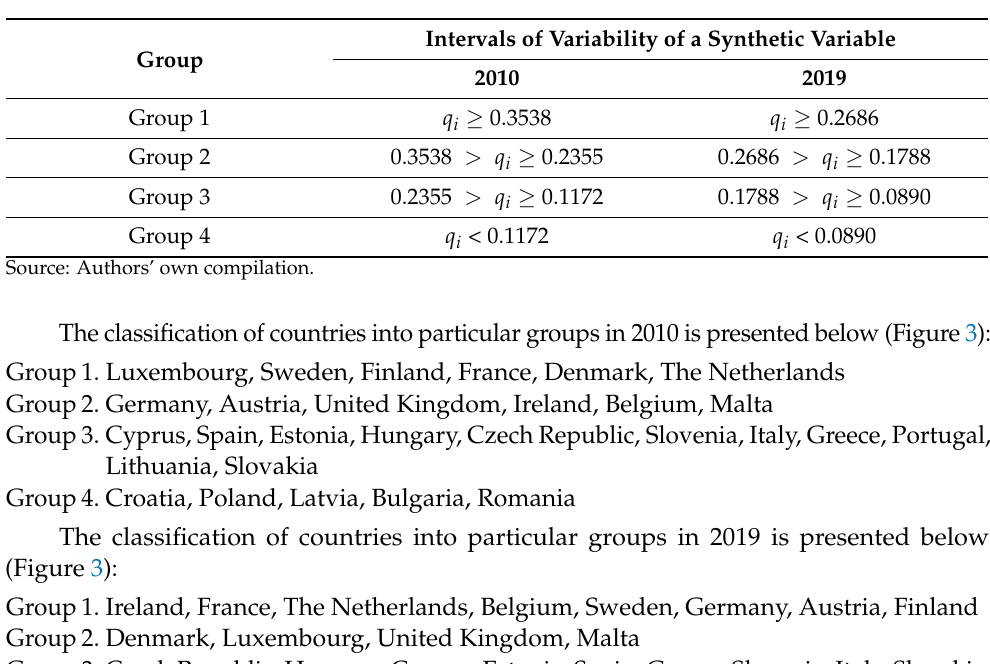
Table 5. The boundaries of groups/classes of the synthetic Hellwig index of EU innovation in 2010 and